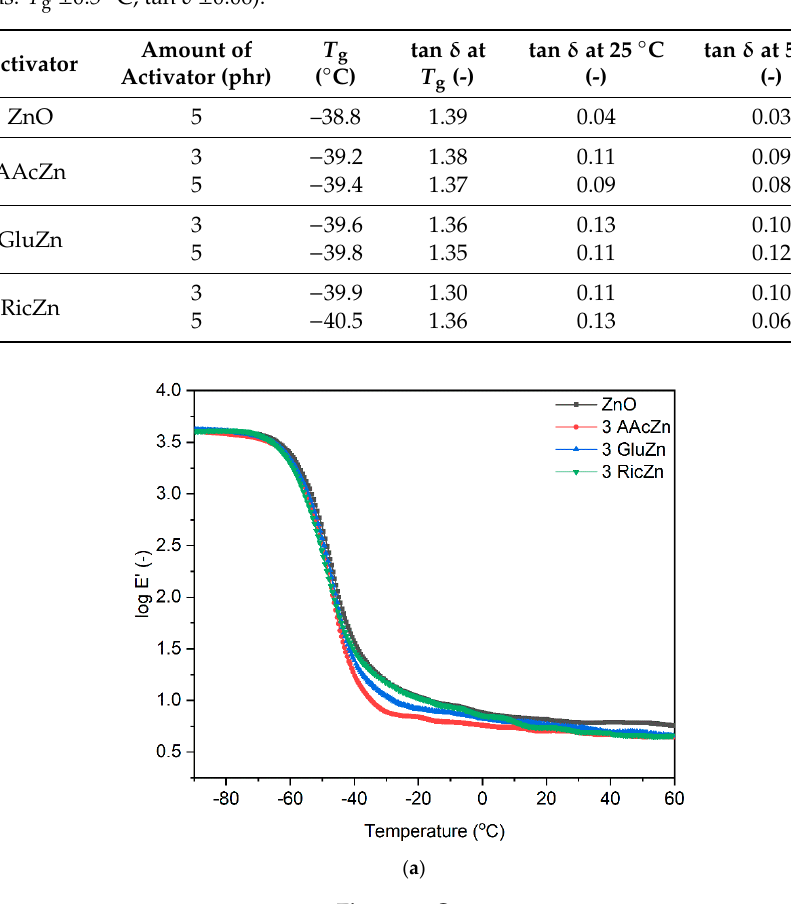
Table 6. Glass transition temperature ( T g ) and loss factor (tan δ ) of SBR vulcanizates (standard deviations: T g ±0.5 °C, tan δ ±0.06).